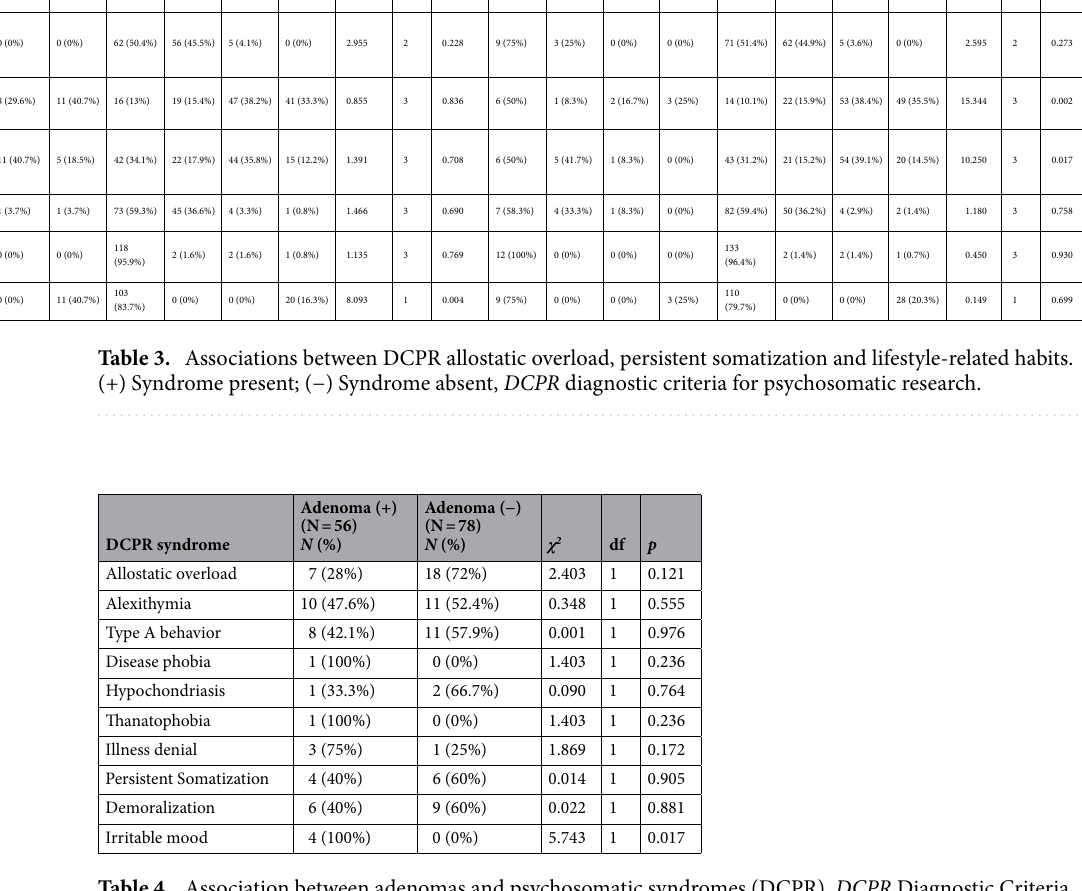
Concerning lifestyle-related behaviors, we found impressive results in our total sample. Indeed, participants reported no or poor physical activity (over 70% of the sample), poor consumption of vegetables (over 30%), fruit (one quarter), dairy products (half), whereas nearly 60% reported no consumption of fish. Findings of the present investigation suggest a possible role of psychosomatic syndromes. Indeed, significant associations between DCPR psychosomatic syndromes, in particular persistent somatization and allostatic overload, and unhealthy behaviors have been found. Persistent somatization seems to be associated to a lower consumption of dairy products and fruit. This finding is in line with few studies in literature. Trabal et al. 52 found that the most prevalent restrictions in patients with chronic fatigue syndrome, which is characterized by enduring and long-term somatic symptoms, were related to dairy products and gluten-containing grains. Similarly, Goedendorp et al. 53 found that 70% of patients with chronic fatigue syndrome had unhealthy fat, fruit and vegetable intake. The same has been found for patients with fibromyalgia who had significantly lower mean consumption of different products such as fruits 54 . On the same line, in our study allostatic overload, which reflects the cumulative effects of stressful experiences in daily life 31 and has been shown to affect clinical course and survival in cardiac patients 28,55 , seems to be associated with tobacco smoking. This finding is in line with the results of Sotos-Prieto and colleagues’ study 56 , in which participants with a chronic stress situation were more likely to be smokers. This risky association (i.e., allostatic overload and smoke habit) should be taken particularly into account given its increased risk for cardiovascular health. The role of DCPR irritability found in the present work is noteworthy. The totality of participants who met